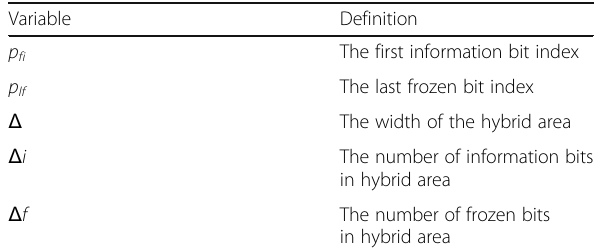
Δ , N − p − 1 when the code fi , lf